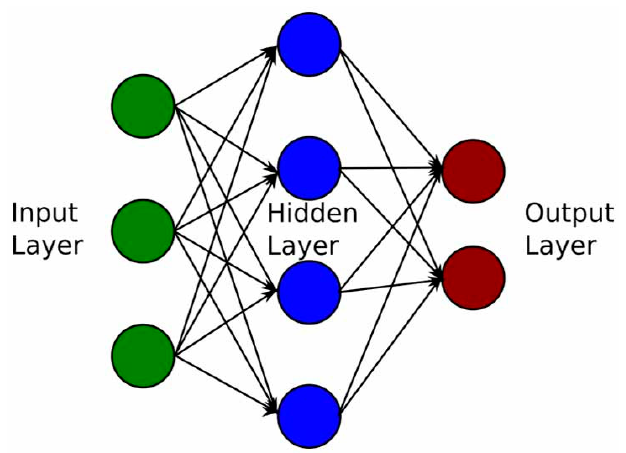
Figure 2. Supervised Learning Back Propagation Neural Network.